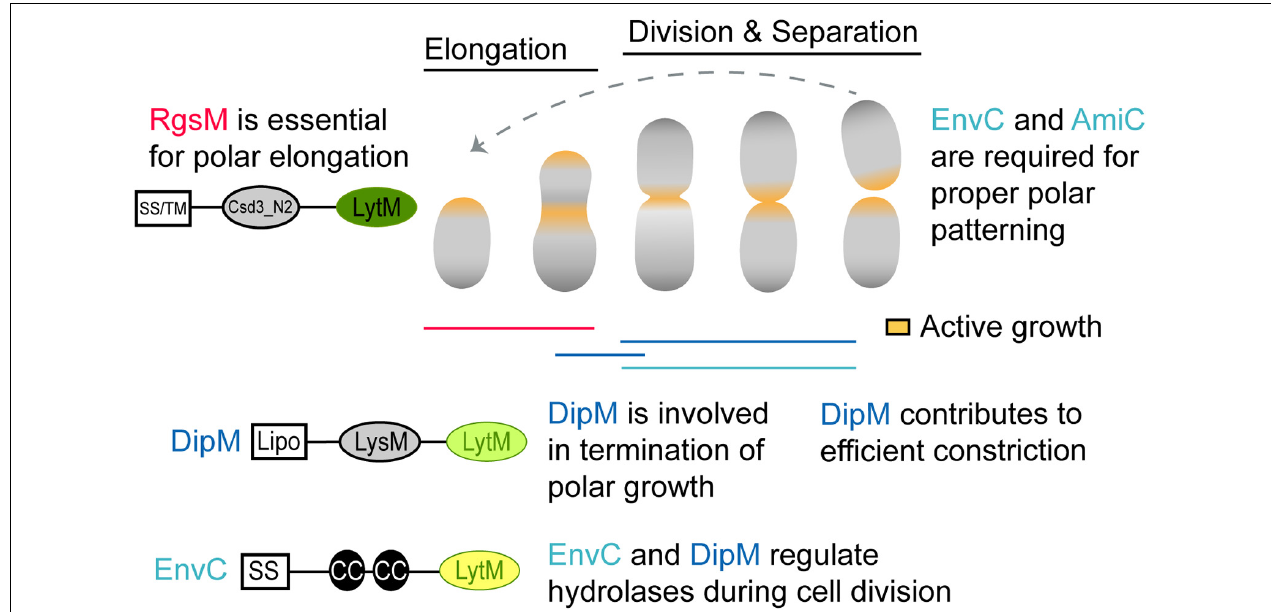
FIGURE 7 | Schematic of proposed LytM factor functions in A. tumefaciens . During polar elongation, the essential RgsM likely functions at the new pole, where it likely modifies the cell wall to allow the addition of new PG material. DipM also localizes to the new pole during polar elongation and polar elongation often fails to terminate in absence of DipM, suggesting that DipM may interact with the elongasome and cell wall hydrolases to help regulate unipolar growth. In the absence of DipM the redirection of growth to mid-cell occurs but frequently leads to mid-cell bulges rather than cell division suggesting that DipM likely regulates PG hydrolases involved in early stages of cell division. Finally, EnvC regulates the activity of AmiC at mid-cell during cell division. While this is a canonical function for a dLytM factor, EnvC and AmiC are not required for cell separation but rather for proper establishment of growth poles following cell division. Protein schematics are shown as described in Figure 1